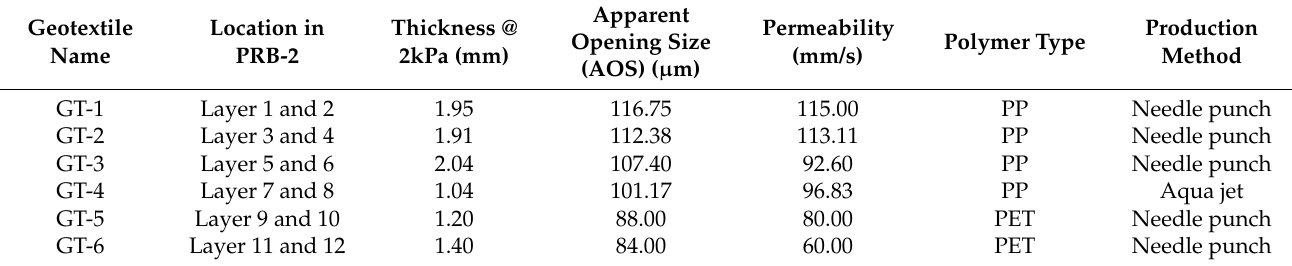
Table 4. Properties and locations of geotextile fabrics used in